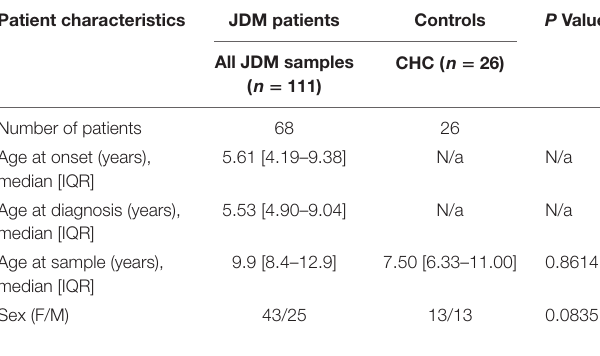
TaBle 1 | Demographic of the juvenile dermatomyositis (JDM) cohort and child healthy controls (CHCs).